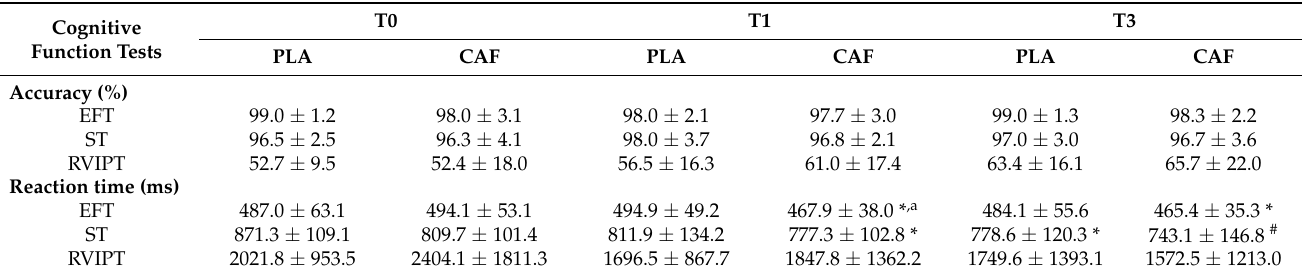
Table 2. Results of accuracy and reaction time of cognitive function